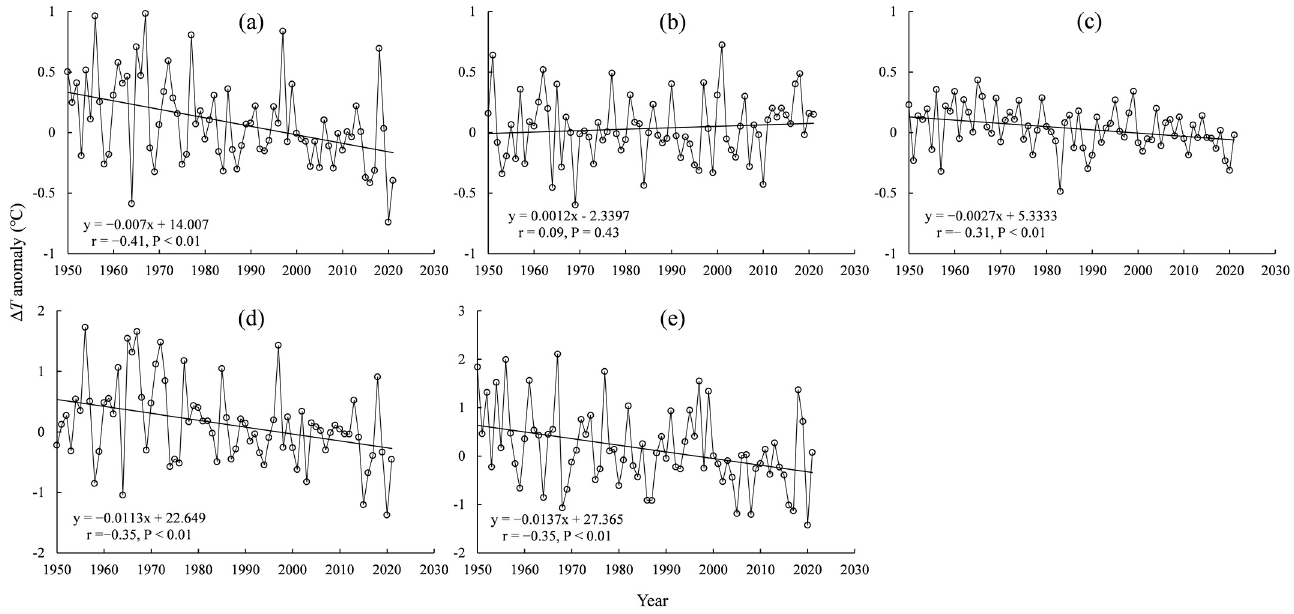
Figure 3. Changes in the mean Δ T on the QTP based on a time series of anomalies (with respect to the mean of the 30-year baseline period, i.e., 1981–2010) from 1950 to 2021; annual ( a ), spring ( b ), summer ( c ), autumn ( d ) and winter ( e ).